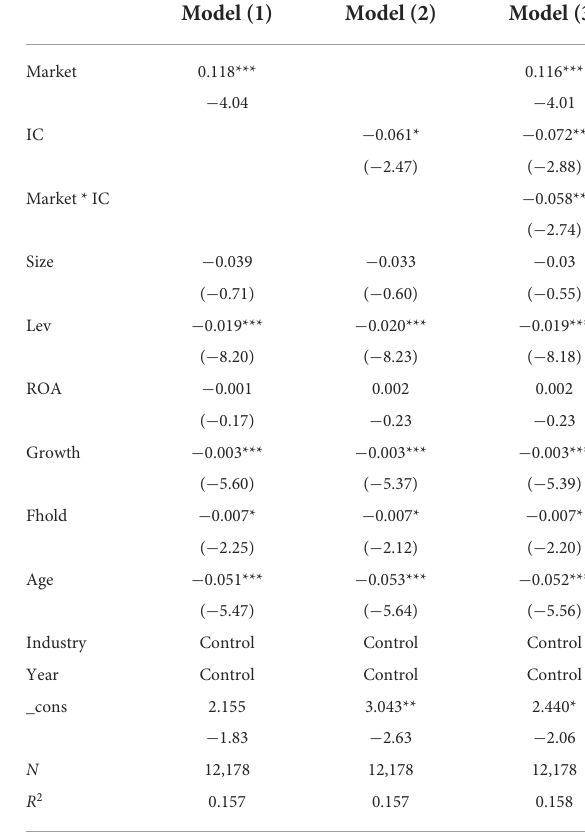
TABLE 4 Regression analysis results of government intervention, internal control quality, and enterprise technological innovation.